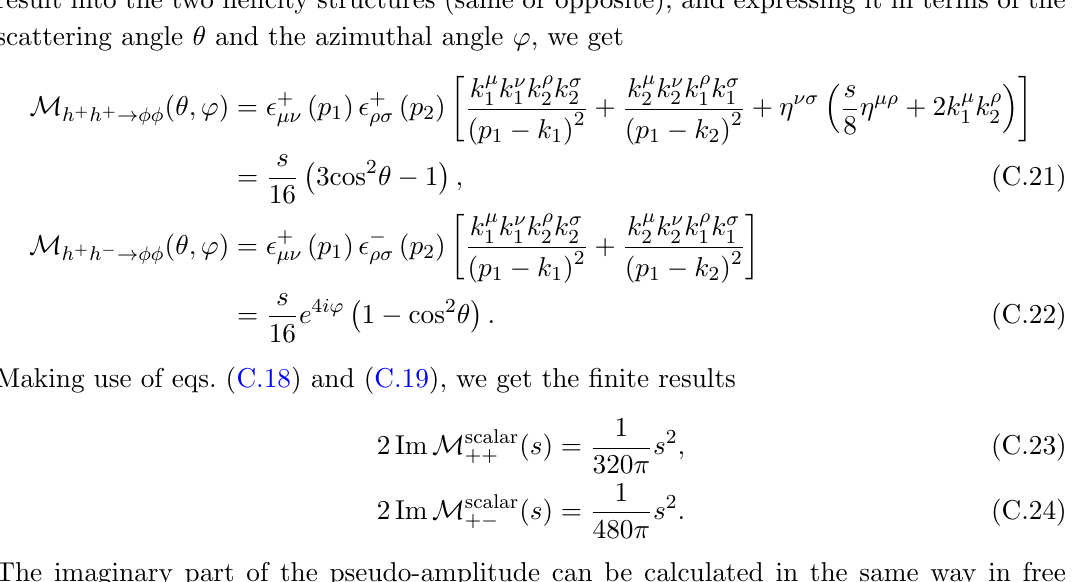
Note the presence of the symmetry factor 1 = 2 due to identical (cid:12)nal-state particles. There are three diagrams for the scattering amplitude M